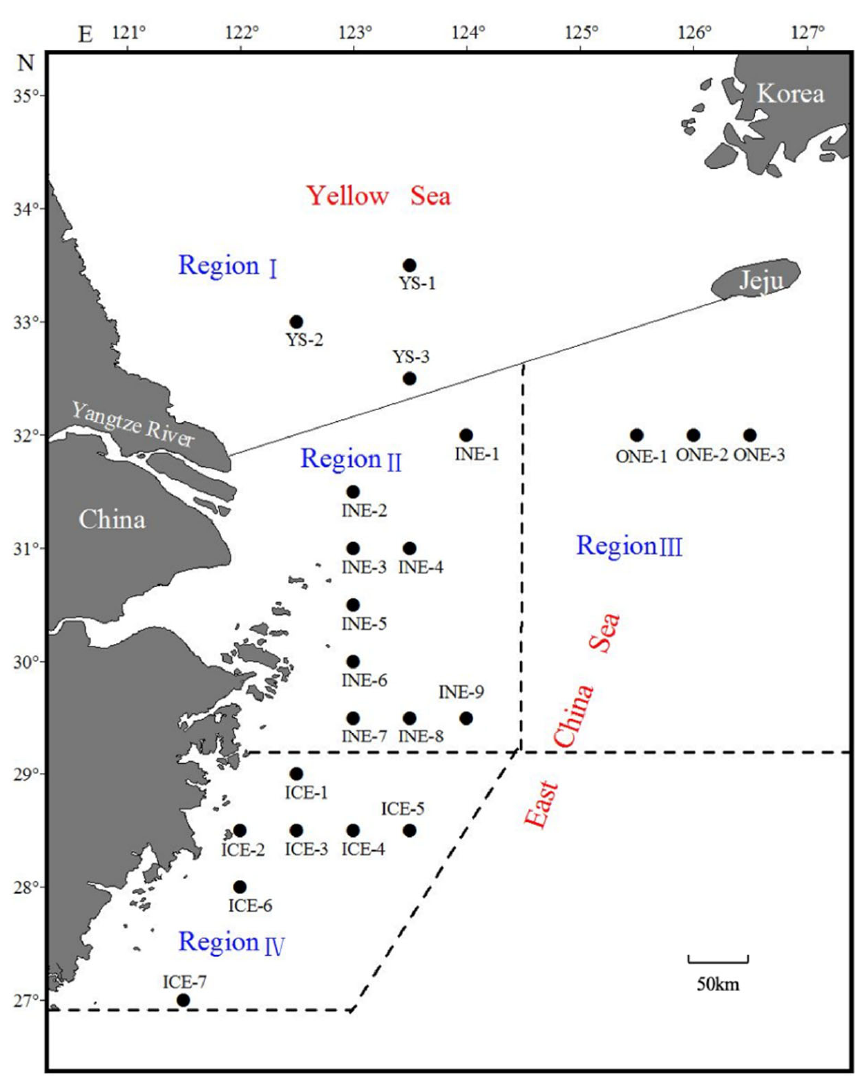
Figure 1. Sampling sites of the large yellow croaker.